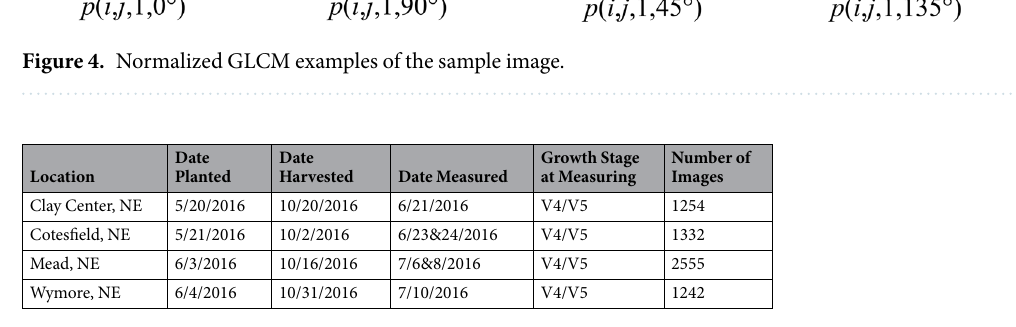
Table 2. Soybean plot and data collection